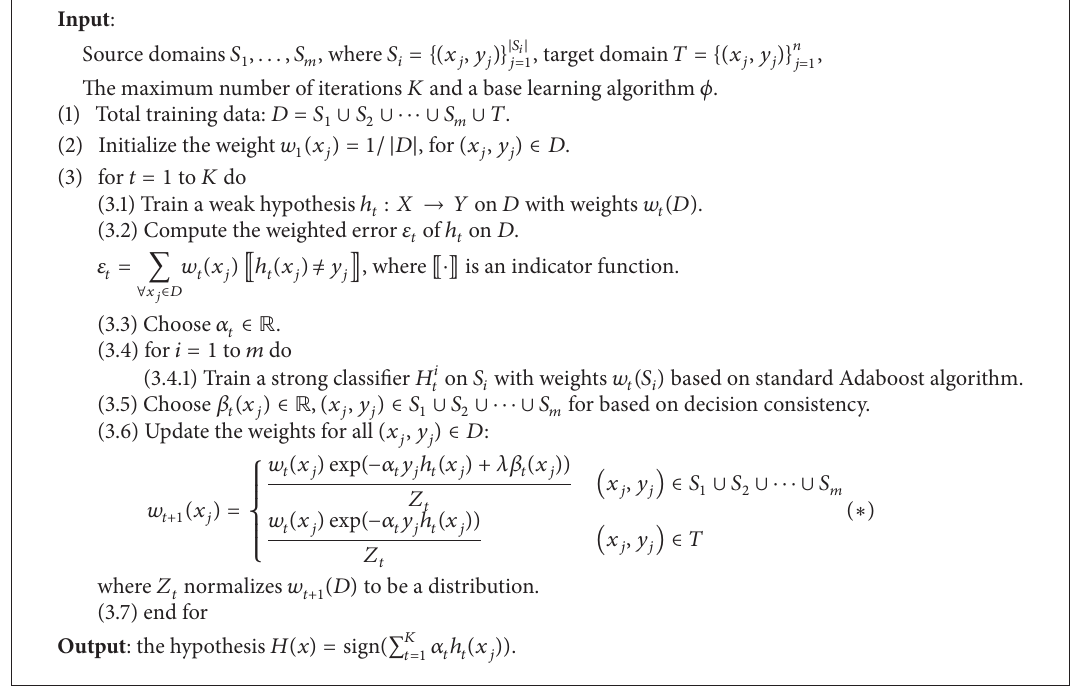
Algorithm 1: The proposed domain adaptation